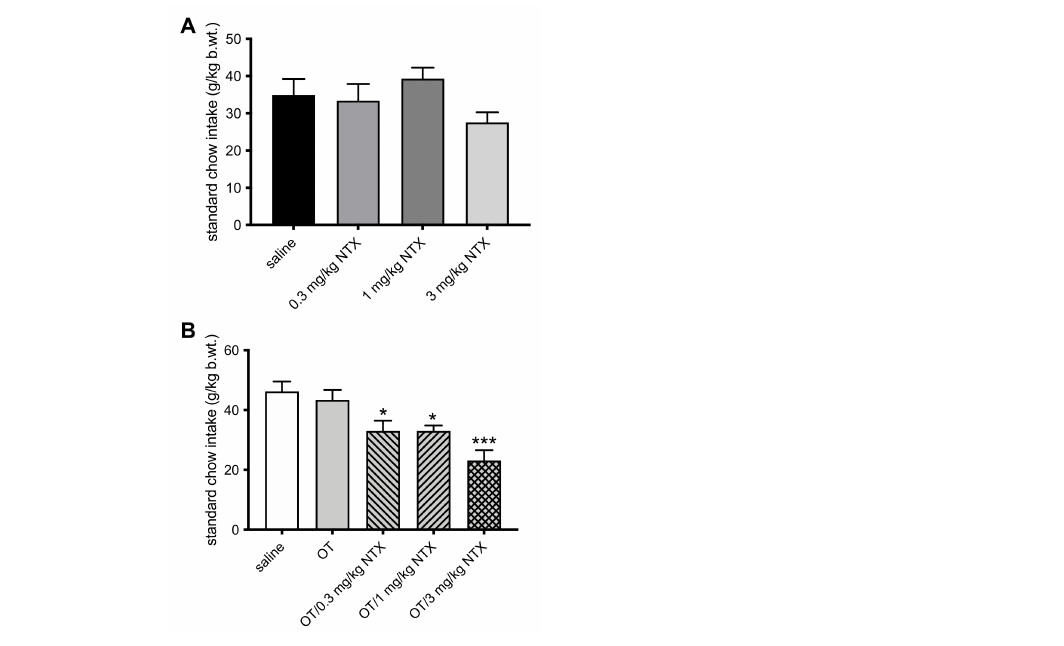
Figure 4. Overnight deprivation-induced standard chow intake (2 h meal) in rats injected IP with: ( A ) saline, 0.3 mg/kg NTX, 1 mg/kg NTX, or 3 mg/kg NTX; or ( B ) saline, 0.1 mg/kg OT, 0.1 mg/kg OT + 0.3 mg/kg NTX, 0.1 mg/kg OT + 1 mg/kg NTX, or 0.1 mg/kg OT + 3 mg/kg NTX. * − p < 0.05; *** − p < 0.001 (significantly different from saline controls).